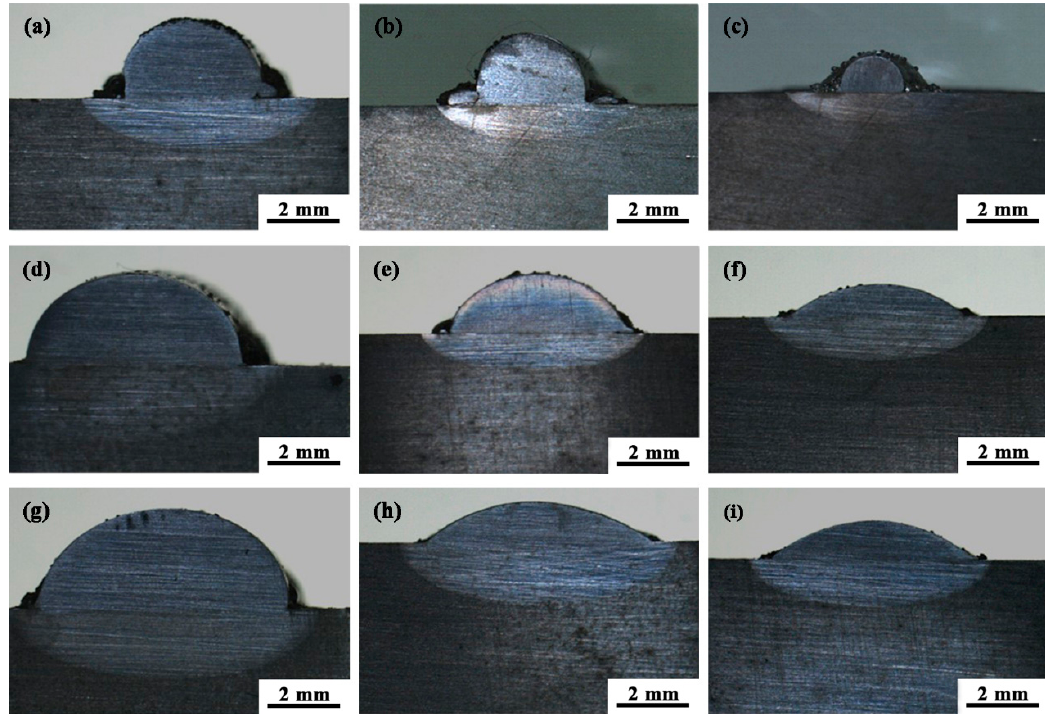
Figure 3. The macro morphology of cladding layer obtained by different processes: ( a ) No. 1 group;